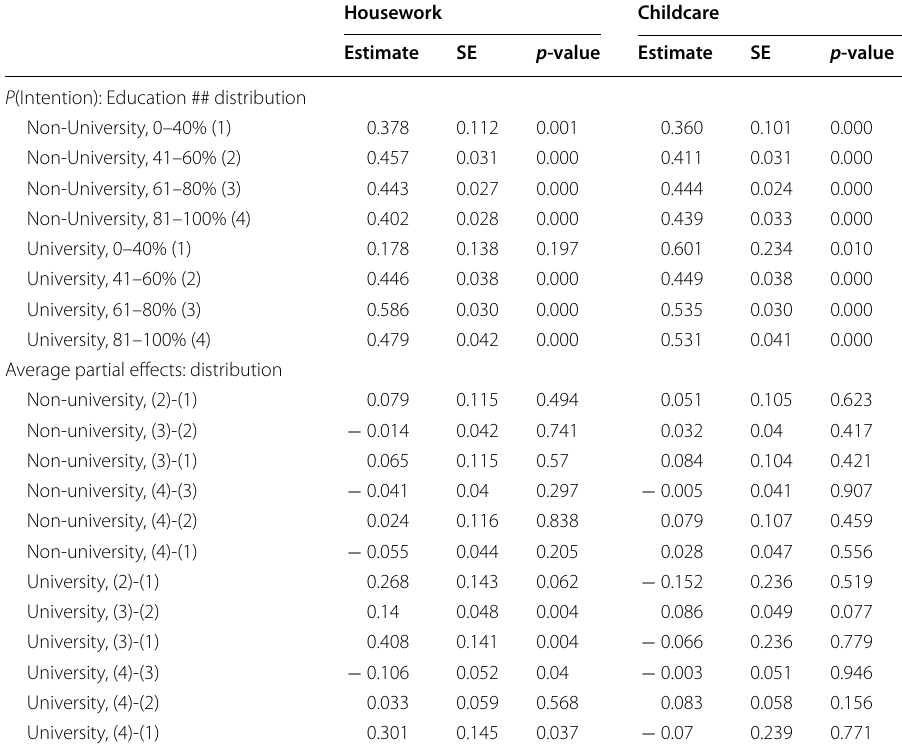
Table 6 Predicted probabilities and average partial effects of the interaction in Model 3 Housework Childcare Estimate SE p ‑value Estimate SE p ‑value